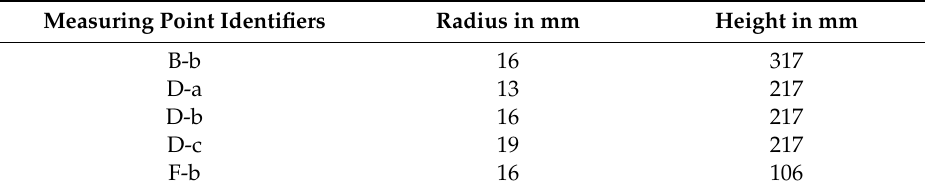
Table 2. Material properties of RT 35—nowadays called RT 35 HC.